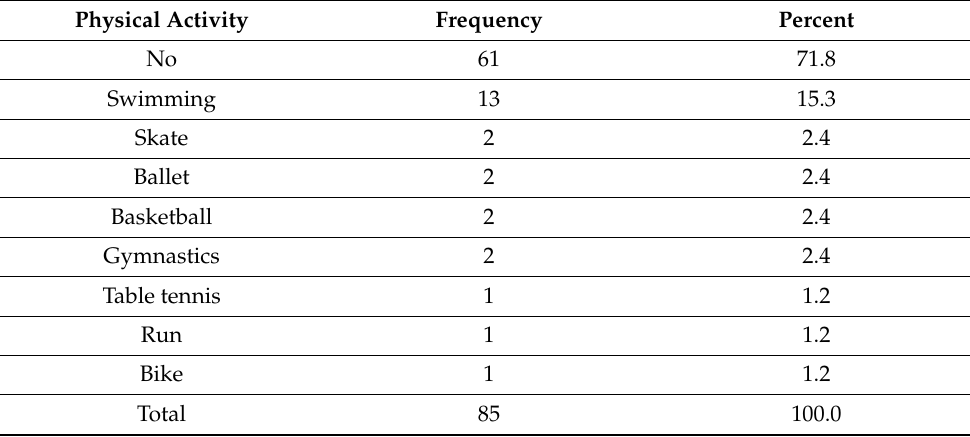
Table 5. Physical activities that individuals with ASD participate in other than APA they receive.